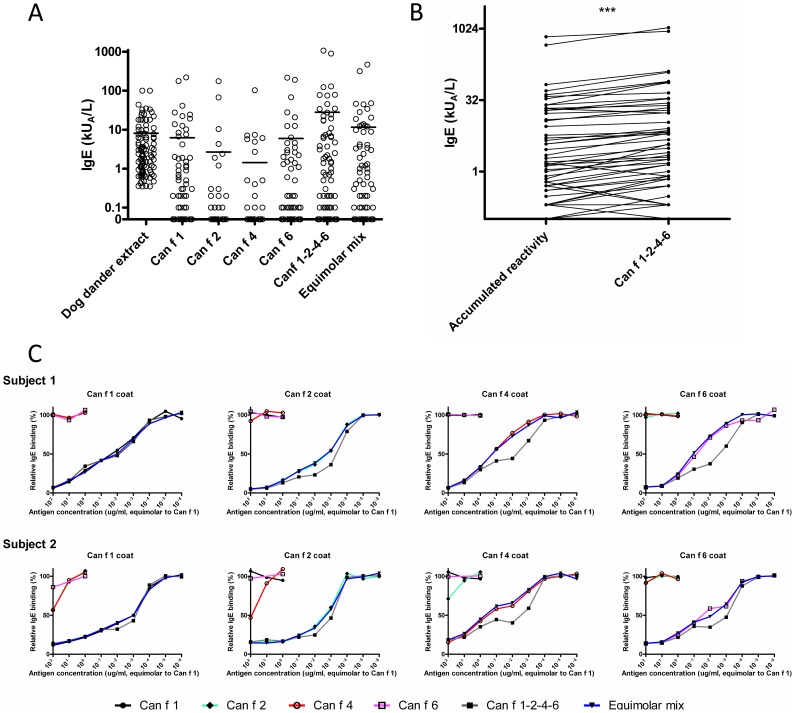
IgE-binding properties of the linked construct.(A) IgE-reactivity of 100 consecutive dog-sensitized subjects (e5, >0.35kUA/L, ImmunoCAP, Thermo Fisher scientific) towards dog extract, Can f 1-2-4-6, the single allergens rCan f 1, rCan f 2, rCan f 4 and rCan f 6, or an equimolar mix of the same allergens. Bars denote mean values. Data are presented as adjusted kUA/L. (B) Pair-wise comparison of accumulated IgE-reactivities to Can f 1, Can f 2, Can f 4 and Can f 6 among positive subjects with reactivity to Can f 1-2-4-6. *** p<0.001 (Wilcoxon matched pairs test) (C) Competitive inhibition ELISA with sera from subjects sensitized to rCan f 1, rCan f 2, rCan f 4 and rCan f 6. After pre-incubation of sera with 10-fold dilutions of equimolar amounts of each recombinant allergen, mix or Can f 1-2-4-6, IgE-responses were measured. Inhibition was calculated as response in percentage (%) of response to the coated antigen after allergen addition (y-axis). Subject 1 and 2 respectively correspond to subject 8 and 21, Table S3 in File S1.